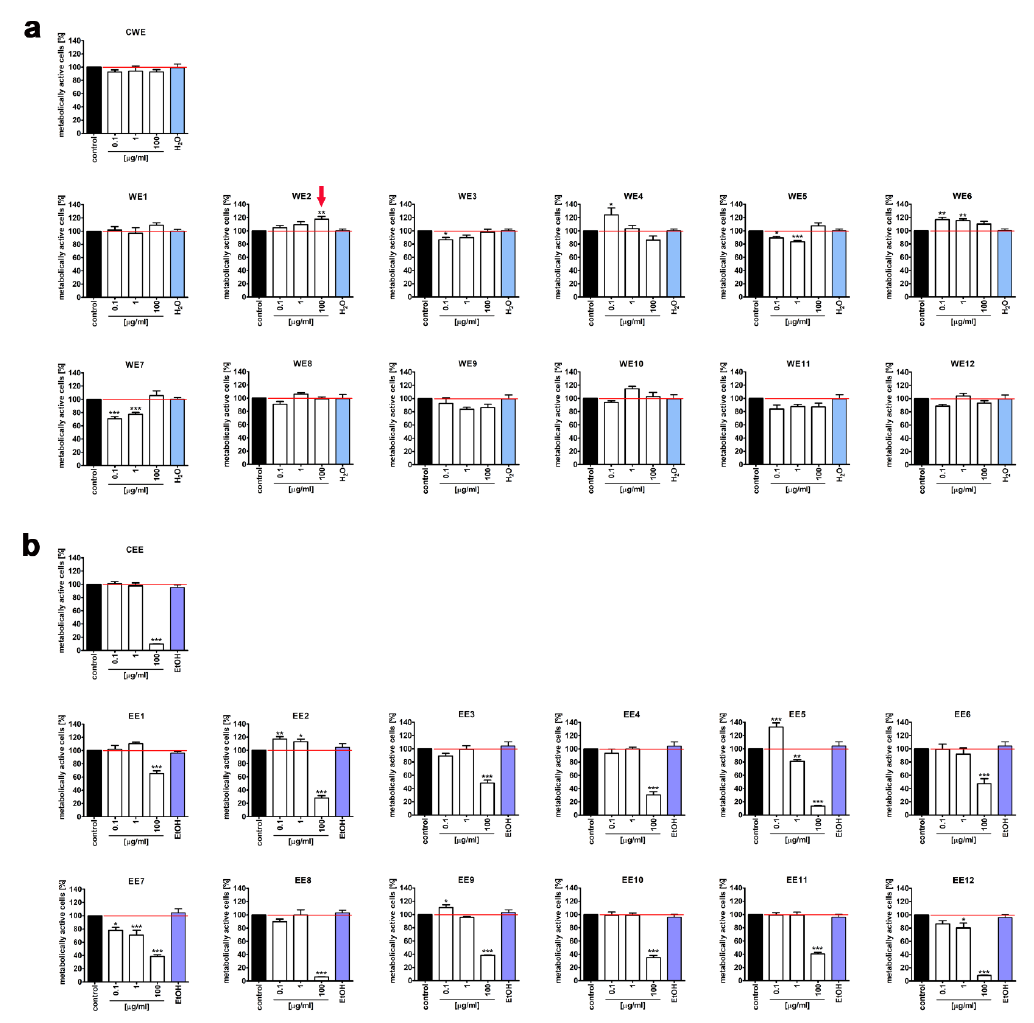
e ff ect on the metabolic activity of HEK cells was limited to 100 µ g / mL WE2 (Figure 2a, a red arrow). There are no literature data on the e ff ects of Chlorella sp. extracts on normal keratinocytes in vitro. The e ff ect of two extracts obtained from two di ff erent microalgal species derived from the Blue Lagoon, namely coccoid and filamentous algae, on the vitality of primary human epidermal keratinocytes was studied [25]. Coccoid algae extract (157 µ g / mL, p < 0.05) promoted cell viability, whereas filamentous algae extract, when used from the concentration of 12 µ g / mL, stimulated cytotoxic e ff ect ( p < 0.05) [25]. However, the authors did not provide information about the microalgal species used [25]. It has also been reported that 0.1% (1 mg / mL) aqueous crude extract of the cyanobacterium Spirulina platensis caused a 2-fold increase in cell viability of the HS2 human keratinocyte cell line [26]. Nutrients 2020 , 12 , x FOR PEER REVIEW